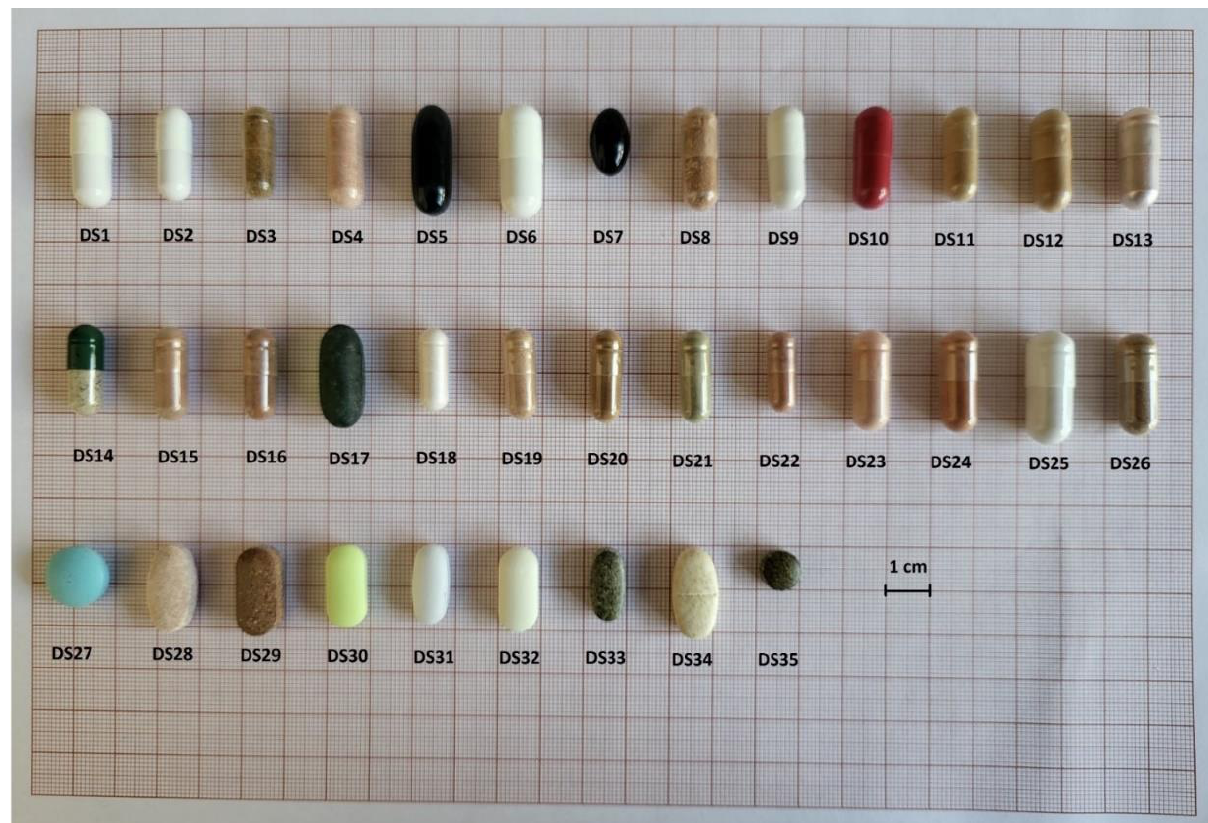
Figure 1. Variation of sizes and shapes of the analysed dietary supplements.